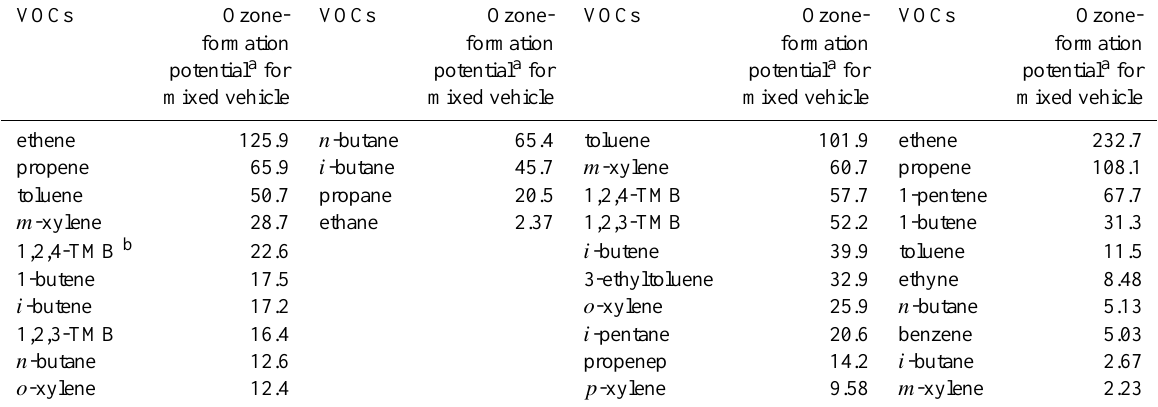
Table 5. Top 10 VOCs for ozone-forming potential of LPG, gasoline and diesel-fueled vehicles emissions estimated at Shing Mun Tunnel. VOCs Ozone- VOCs Ozone- VOCs Ozone- VOCs Ozone- formation formation formation formation potential a for potential a for potential a for potential a for mixed vehicle mixed vehicle mixed vehicle mixed vehicle ethene 125.9 n -butane 65.4 toluene